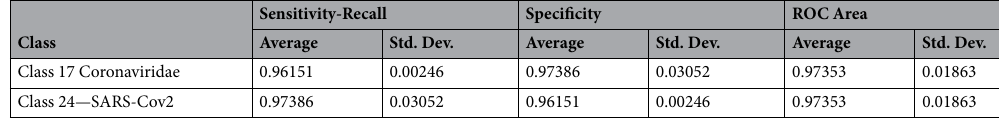
Table 3. Results of Sensitivity, specificity, and ROC area for MLP binary classifier (Coronavirus vs. SARS- CoV-2 using the 30% overlap dataset).